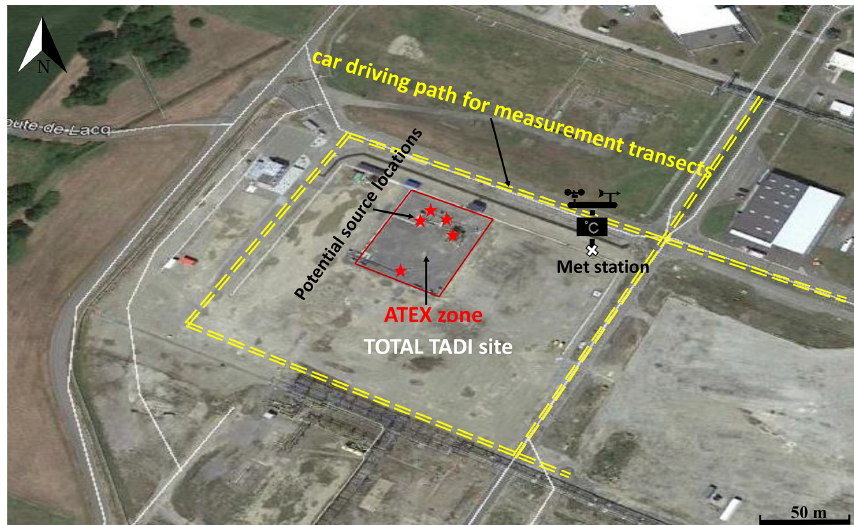
Figure 1. A schematic of the experimental setup on the top of the satellite image of the TADI platform (source: Google Earth © Google Earth). The red stars show some of the possible approximate location of the emission sources in the ATEX zone (rectangle with red colored line). The full set of exact locations used for the releases is detailed in Fig. S1 of the Supplement. A hybrid SUV drove in electric mode on the road next to the site, along the yellow colored double dotted lines. The meteorological station installed and operated by TOTAL was located at the basis of its black symbol.